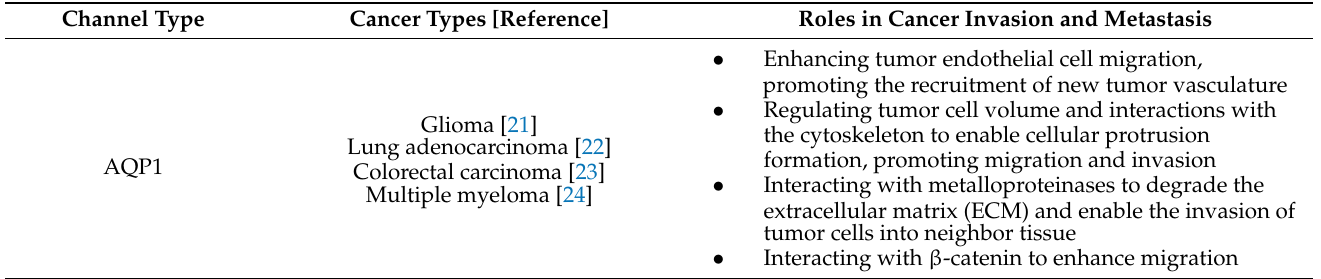
Table 1. Proposed roles for aquaporins and aquaglyceroporins in elevating invasion and metastasis in different types of cancers, with cited references in